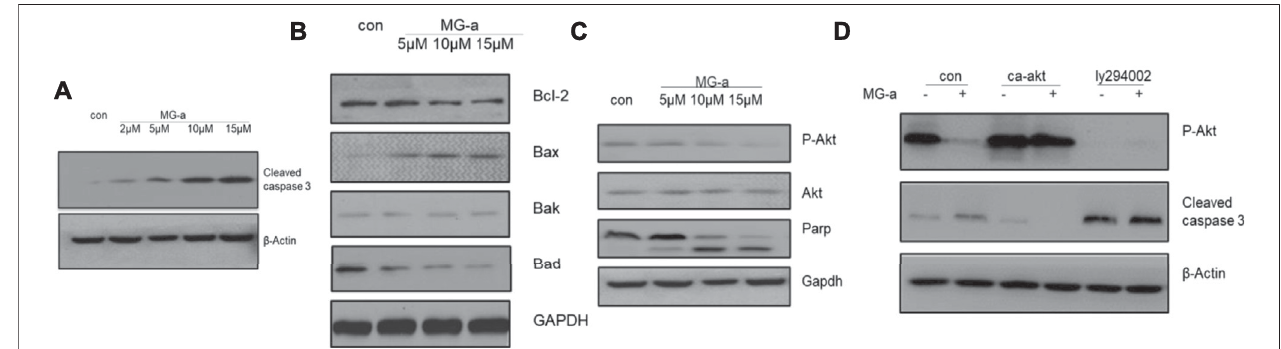
FIGURE 2 | The apoptotic effects of α -mangostin depend on the PI3K/Akt signaling pathway. Cell apoptosis in MDA-MB-231 cells treated with α -Mangostin depends on the PI3K/Akt signaling pathway. (A) The expression levels of cleaved caspase-3 were determined by western blotting analysis in MDA-MB-231 cells after α -Mangostin treatment. (B) The expression levels of BCL-2 family proteins were determined by western blotting analysis in MDA-MB-231 cells after α -Mangostin treatment. (C) and (D) , The western blotting analysis demonstrated that PI3K/Akt signaling is required for the apoptosis of MDB-MD-231 cells induced by α -Mangostin.